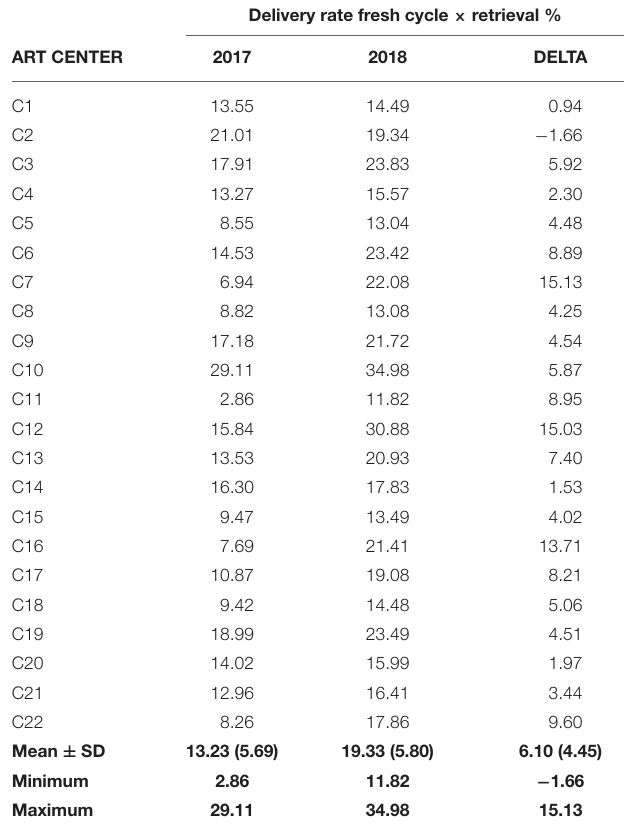
TABLE 2 | Delivery rate % for fresh transfer in the 22 IVF centers in the period